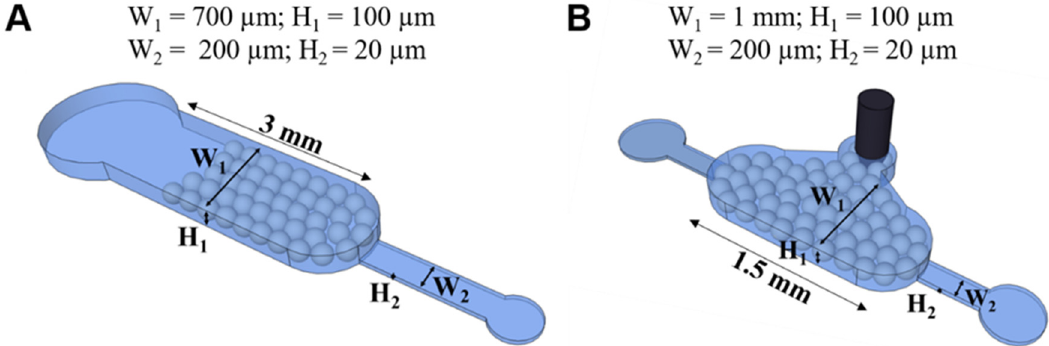
Figure 1. The micro fl uidic structures, packed with beads, for screening studies ( A ) and for detection of AK in assays ( B of AK in assays ( B ).